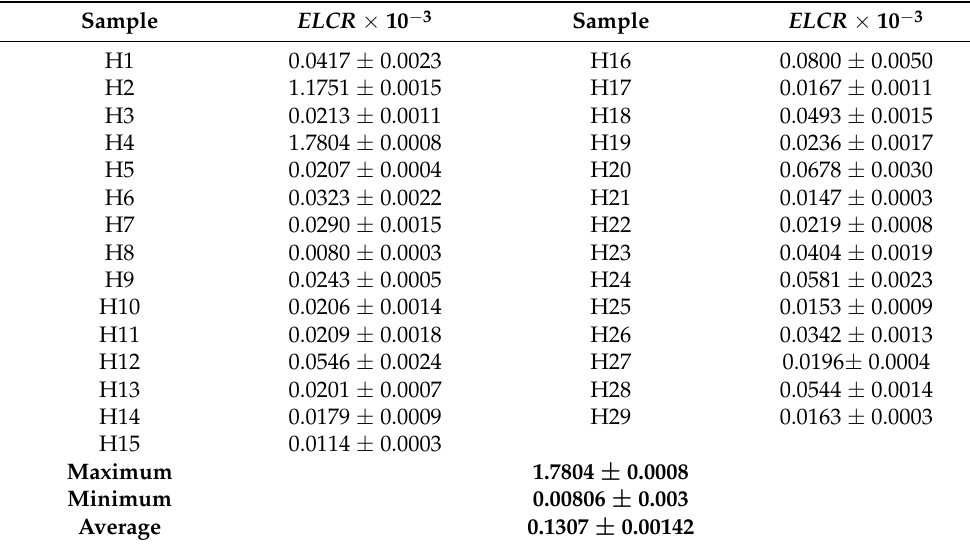
Table 7. The excess lifetime cancer risk ( ELCR ) for the investigated